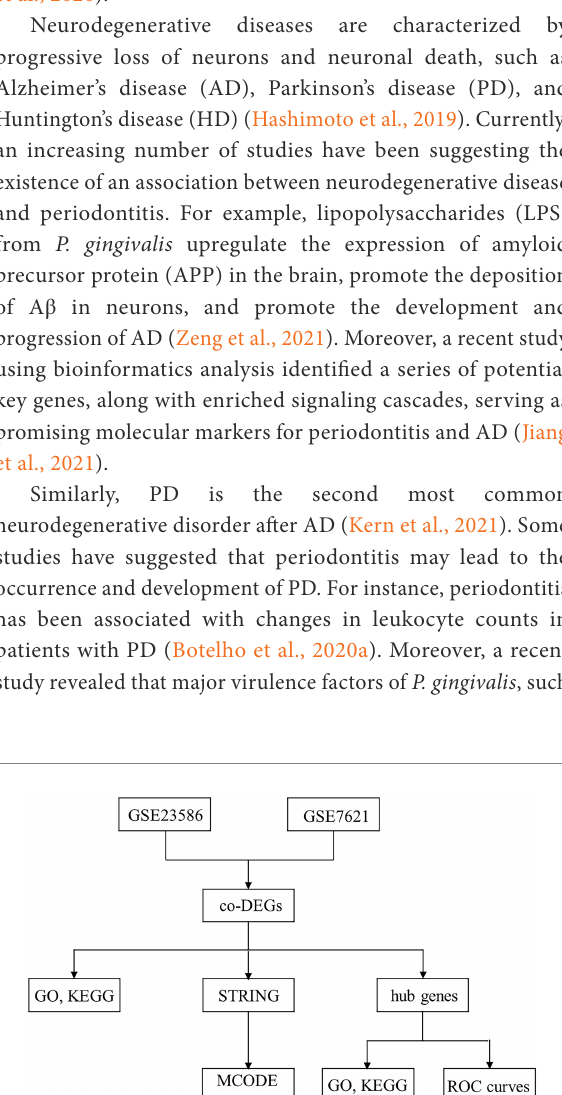
FIGURE 1 Research flow